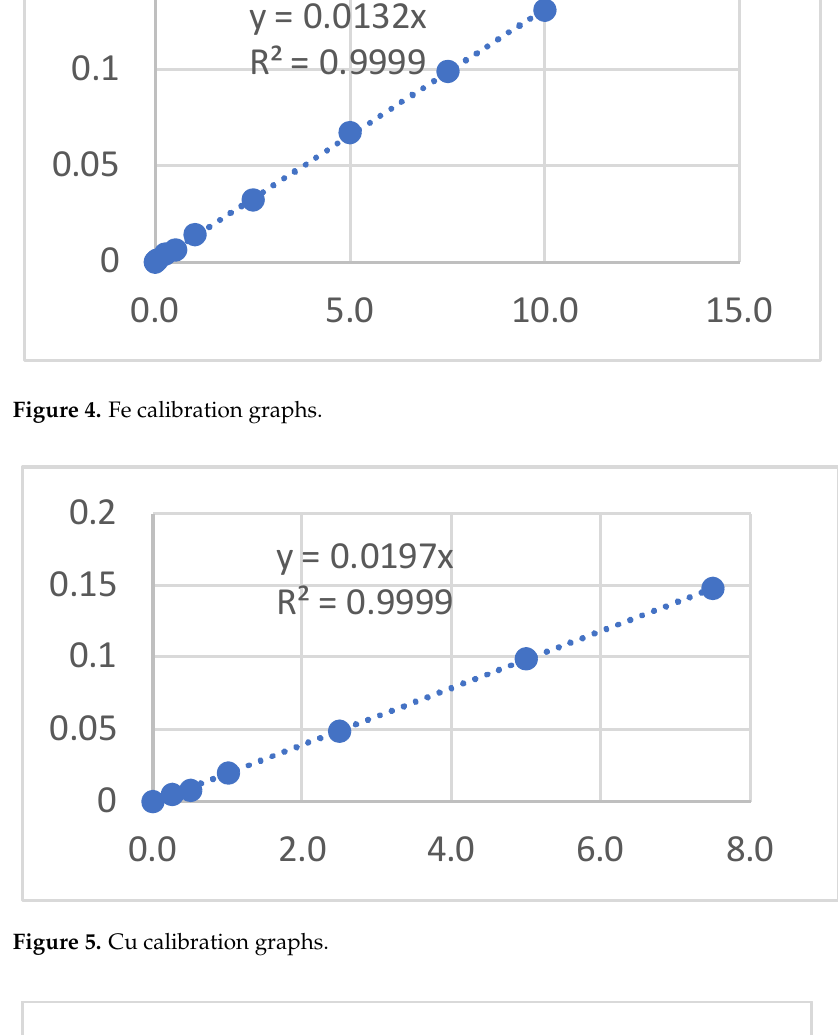
Figure 4. Fe calibration graphs